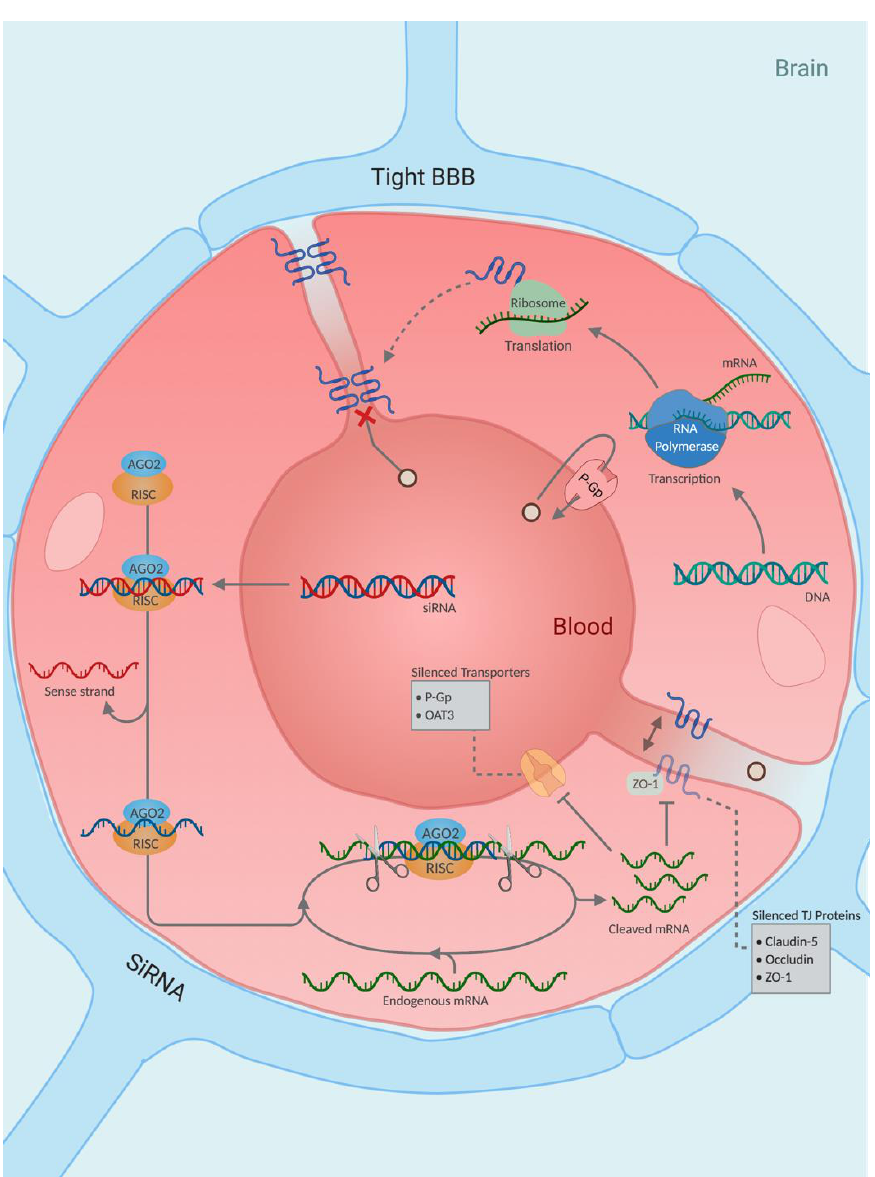
Figure 6. SiRNA Mechanism for blood–brain barrier modulation. siRNAs are derived from double- stranded RNAs of approximately 21 base pairs in length, that when introduced into a cell induce mRNA degradation for RNA of complementary nucleotide sequences, preventing the translation of a particular gene. siRNA has been used to silence transporters and tight junction proteins to modulate the blood–brain barrier. Abbreviations: AGO2 (protein argonaute-2), OAT3 (organic anion transporter 3), P-Gp (P-glycoprotein), RISC (RNA-induced silencing complex), ZO-1 (zonula oc- cludens1).